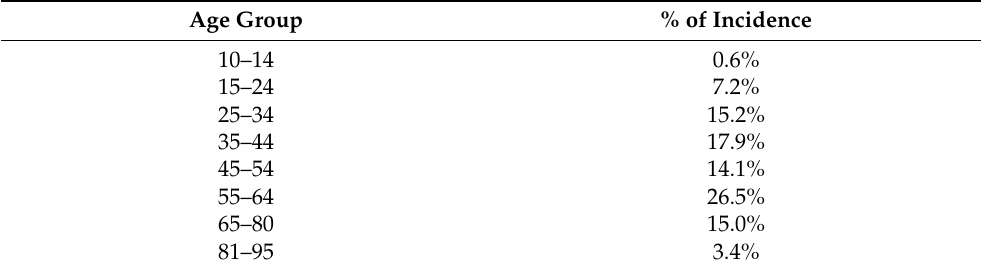
Table 2. Number and percentage of positive incidence for microorganism growth samples by age group.